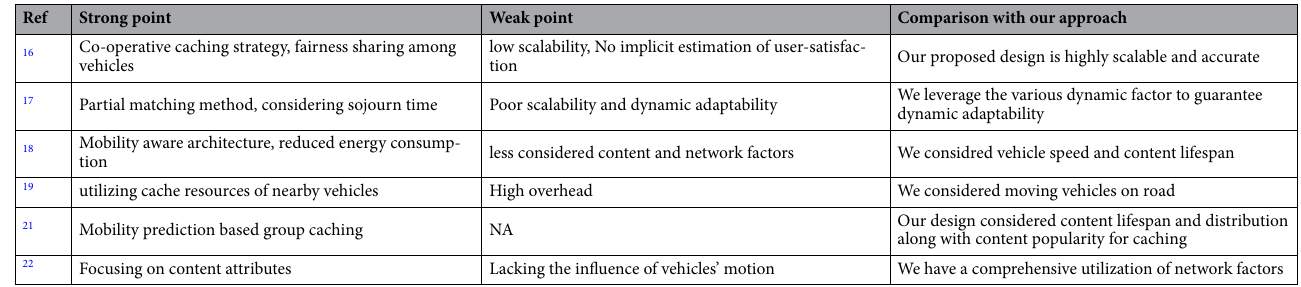
Table 1. Comparison of proposed work with related